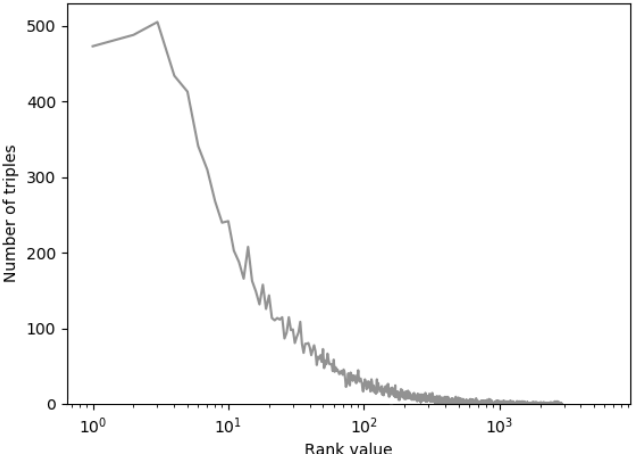
Figure 6. Number of triples for each ranking position obtained by evaluating the best model on the test set. The ranking positions range from 1 to 47,995.